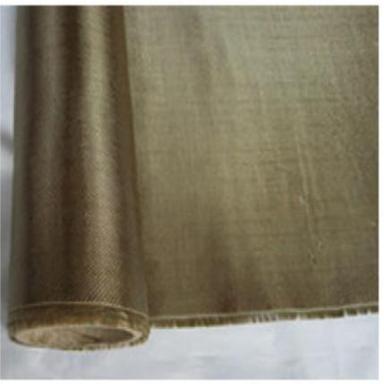
(a) Basalt fiber; Fig.3. (b) Glass fiber.